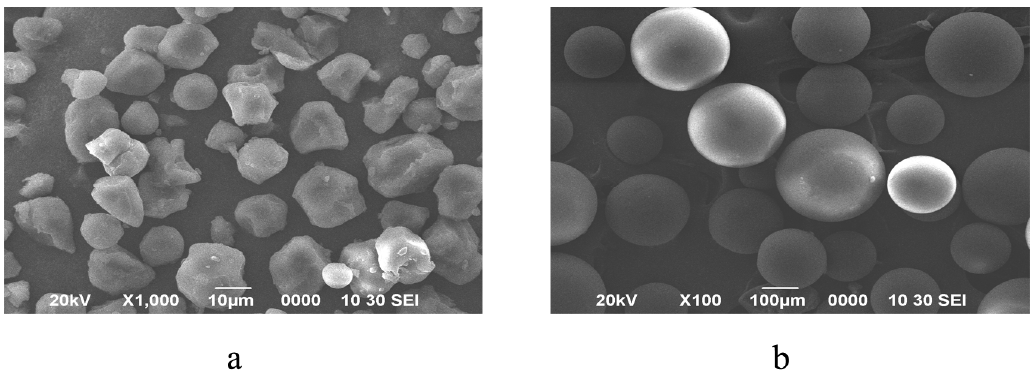
Figure 2. SEM micrographs of surface of HSPH ZZ ( a ) and ImmHSPH ZZ ( b ). Magnification: ( a ) ×1000; ( b ) ×100.